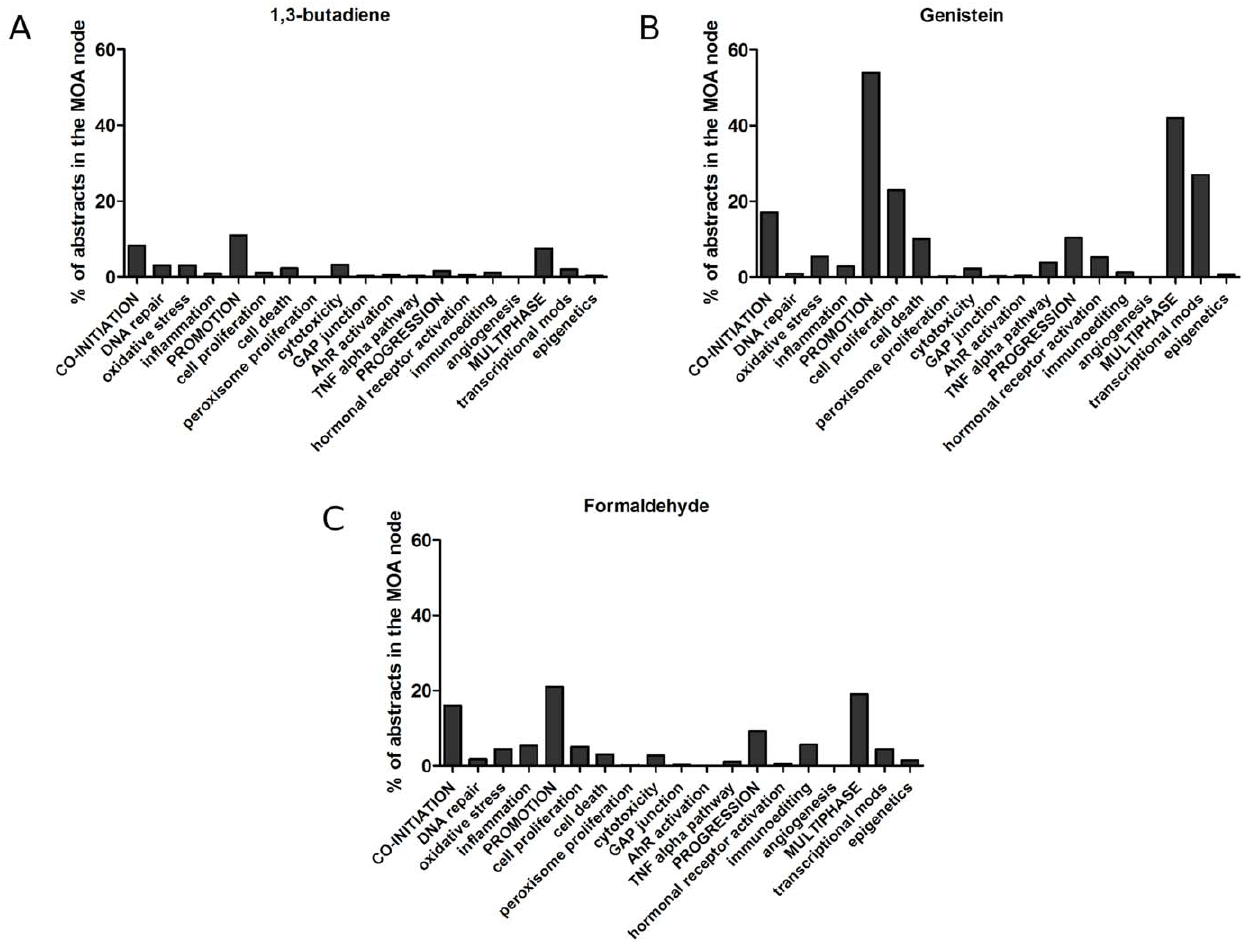
Figure 10. Non-genotoxic Mode of Action: distribution of classified abstracts for three chemicals: 1,3-butadiene, genistein and formaldehyde.